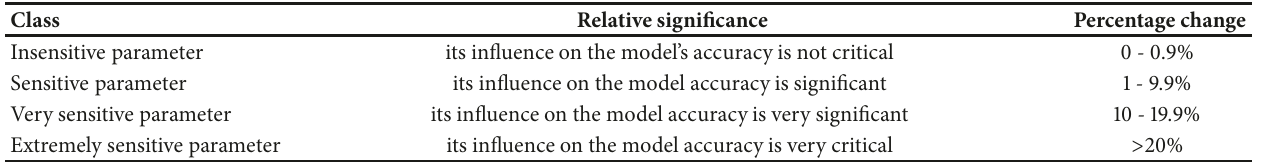
Table 1: Sensitivity classification of modelling